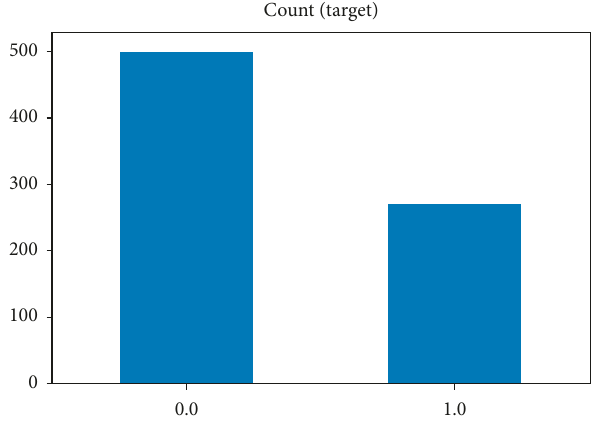
Figure 10: Before augmentation.